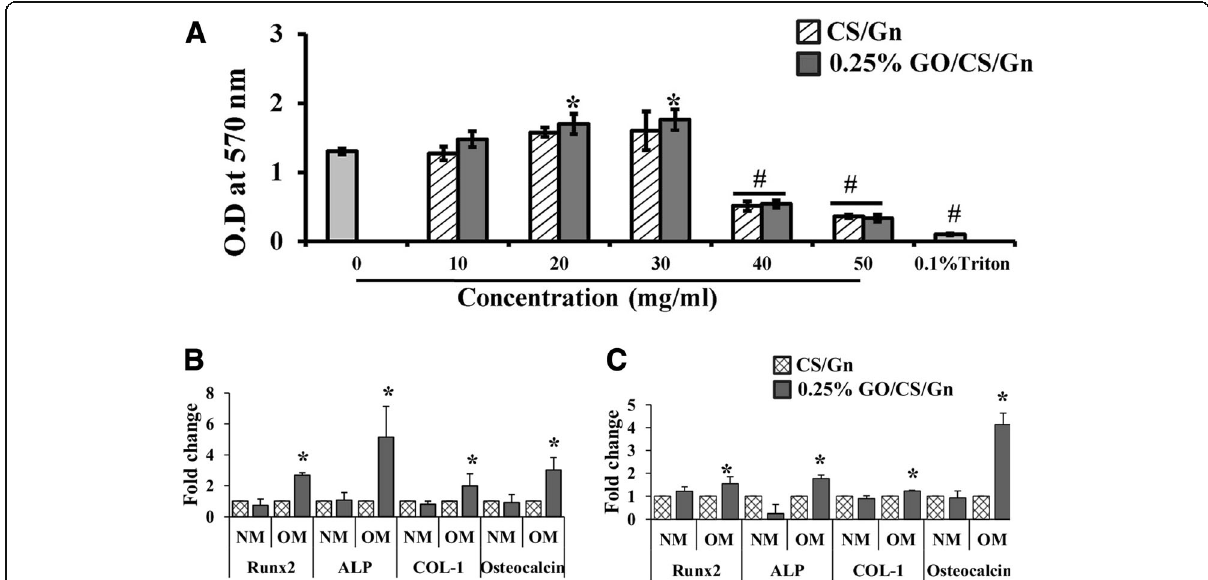
Fig. 5 a MTT assay after incubation of CS/Gn scaffolds and 0.25% GO/CS/Gn scaffolds with media for 48 h. The asterisk indicates a significant increase versus control, and the pound sign indicates a significant decrease versus control ( p <0.05). b , c Expression of osteogenic-related genes (RUNX2, ALP, COL-1, and OC) in mMSCs cultured on CS/Gn scaffolds and 0.25% GO/CS/Gn scaffolds for 7 and 14 days measured by quantitative RT-PCR. Reproduced from ref. [104] with permission from the Journal of International Journal of Biological